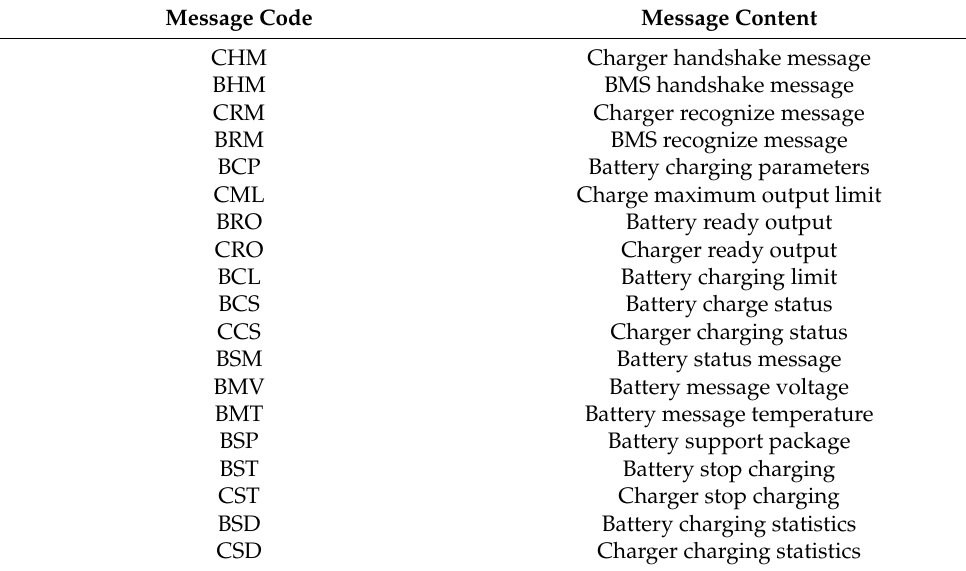
Table 1. Message content table of electric vehicle charging communication system.